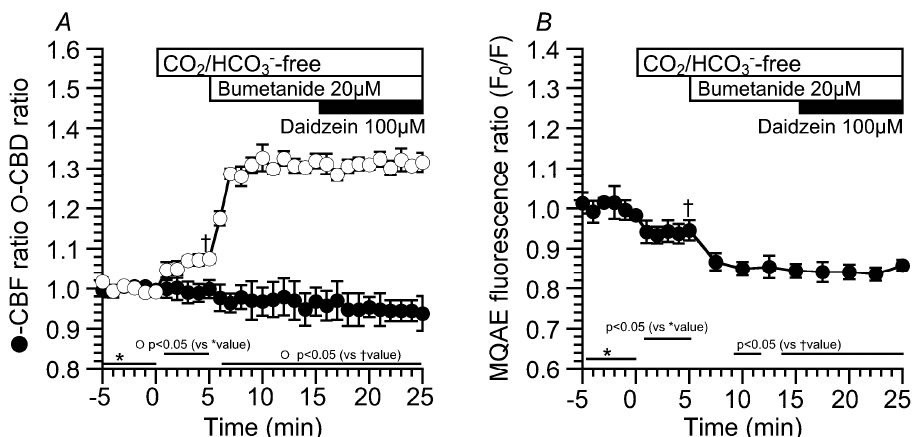
Figure 6. Effects of bumetanide on CBD, CBF, and [Cl − ] i in cHNECs. Experiments were carried out the CO 2 /HCO 3 − -free control solution. ( A ) Changes in CBD and CBF induced by bumetanide. The values of CBD and CBF just before the addition of bumetanide were 1.08 ± 0.01 ( n = 5) and 1.00 ± 0.02 ( n = 5), respectively. The addition of 20 µ M of bumetanide immediately increased CBD, but did not increase CBF. The values of CBD and CBF 10 min after bumetanide addition were 1.32 ± 0.02 ( n = 5) and 0.97 ± 0.03 ( n = 5), respectively. Further stimulation with 100 µ M of daidzein did not change CBD or CBF. The values of CBD and CBF 10 min after daidzein stimulation were 1.32 ± 0.02 ( n = 5) and 0.94 ± 0.04 ( n = 5), respectively. ( B ) Changes in the MQAE fluorescence ratio (F 0 /F). The value of F 0 /F just before the addition of bumetanide was 0.94 ± 0.03 ( n = 4). The subsequent addition of 20 µ M of bumetanide decreased F 0 /F (F 0 /F 10 min after bumetanide addition = 0.84 ± 0.02, n = 4). Further daidzein stimulation did not change F 0 /F.